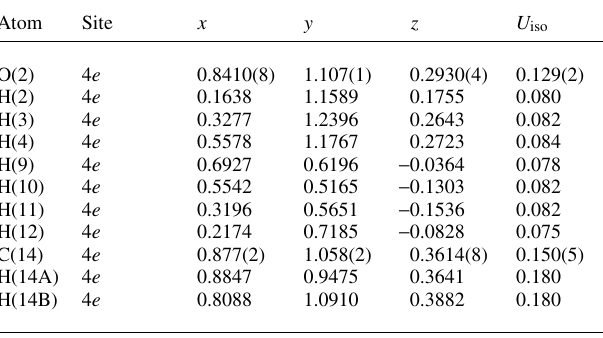
Table 2. Atomic coordinates and displacement parameters (in Å 2 )